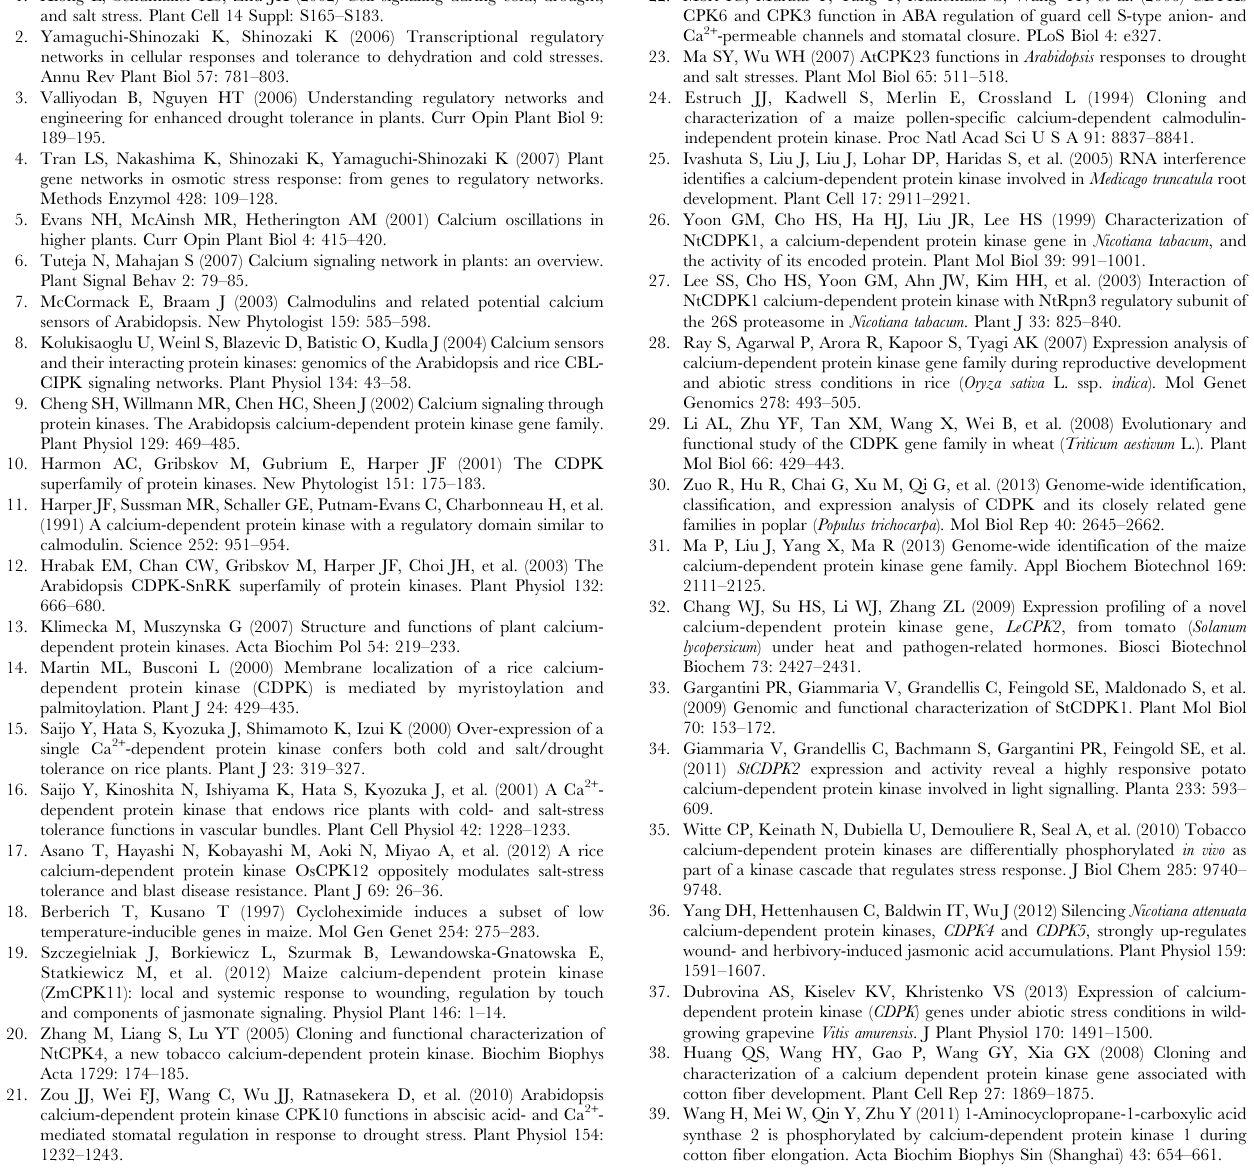
Table S1 PCR primers used in this study. Table S2 The LTRE in the promoter regions of GrCPKs .